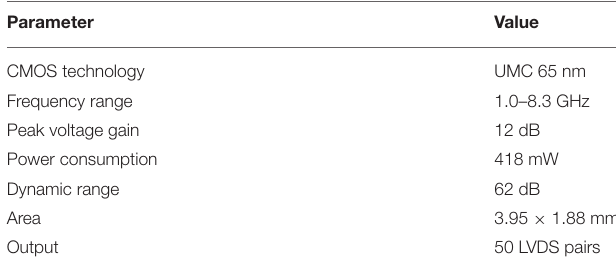
TABLE 1 | Cochlea chip performance summary.